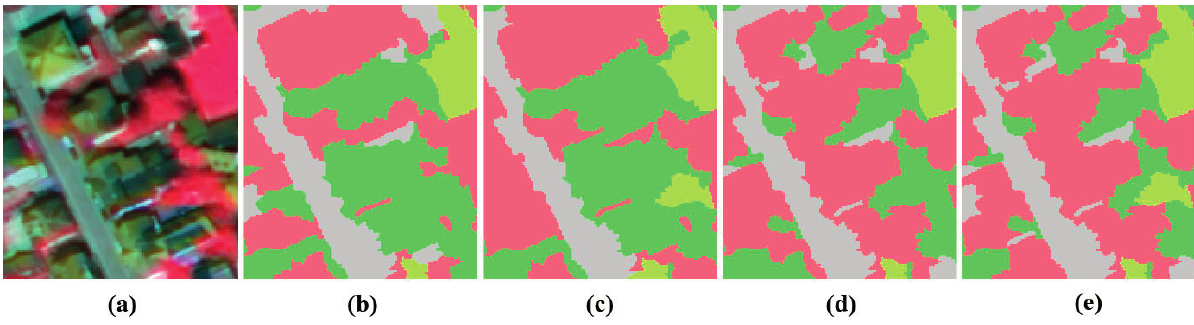
Figure 11. The detailed subset of classification images represented in Figure 10 in relation to the satellite image that was used as an input for the classification process and was also considered as the ground truth image: ( a ) pan-sharpened Worldview-2 image (shown as a false color composite); ( b ) k -NN classifier; ( c ) SVM classifier; ( d ) the two-sample Kolmogorov-Smirnov statistics based classifier; ( e ) the Student’s t -test statistics based classifier. Images reveal higher classification accuracies of the two proposed classifiers compared to the ground truth